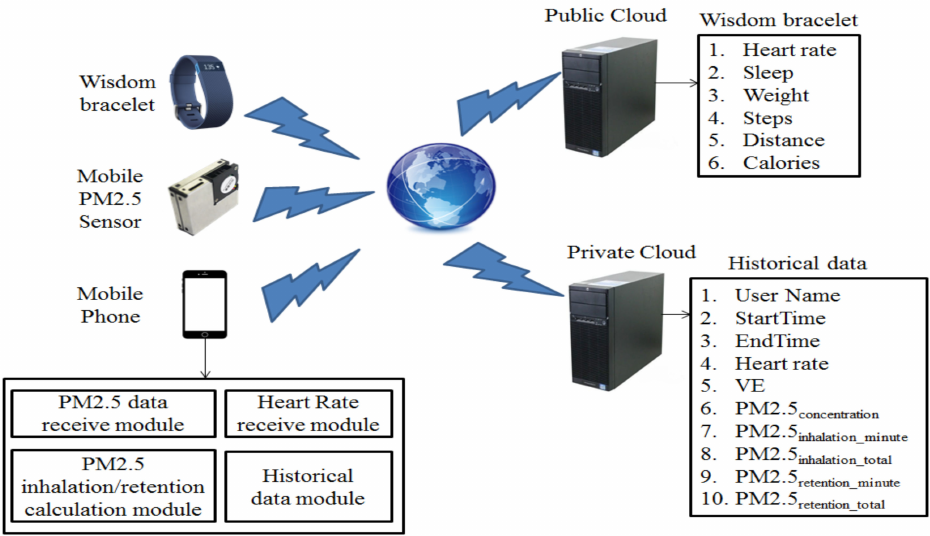
Figure 2. Overall architecture—hybrid cloud-based system